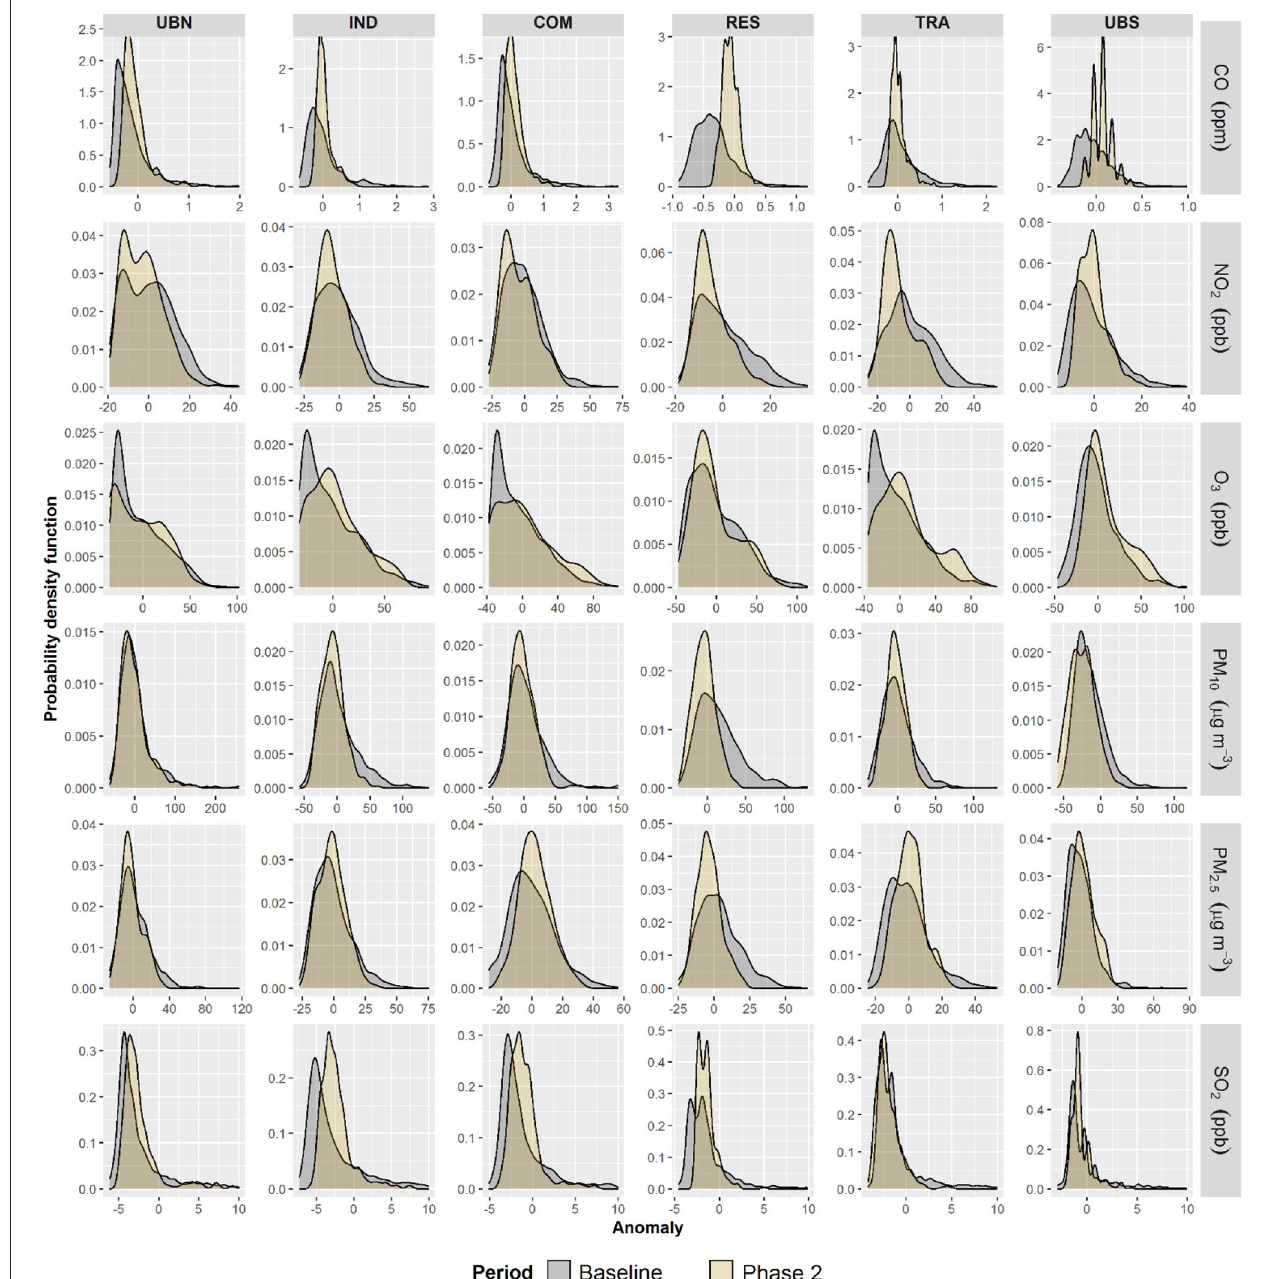
FIGURE 2 | Probability density function plots for hourly anomalies for CO, NO 2 , O 3 , PM 2.5 , PM 10 , and SO 2 during the COVID-19 lockdown Phase 2 and baseline within the MCMA.